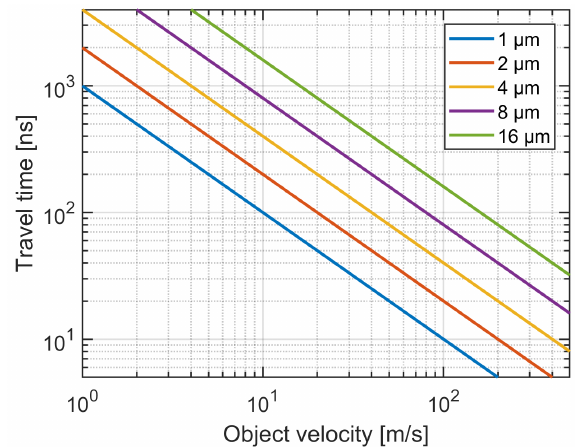
Figure 1. Relationship between travel time and object velocity for a range of linear displacements (see legend) relevant to microscopy in high-speed flows. This graph provides guidance to limit motion blurring to image moving objects at different spatial